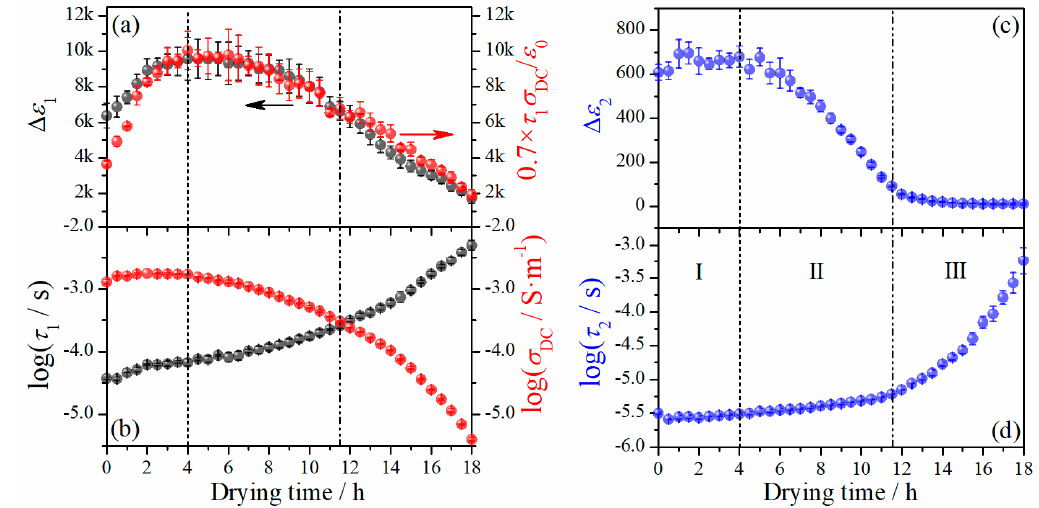
Figure 3. ( a ) Variation of the relaxation strength of relaxation 1 and the product of dc conductivity and relaxation time with drying time; ( b ) variation of relaxation time of relaxation 1 and dc conductivity with drying time; variation of ( c ) relaxation strength and ( d ) relaxation time of relaxation 2 with drying time. The short dash and dash-dot-dot lines indicate the transition moments.